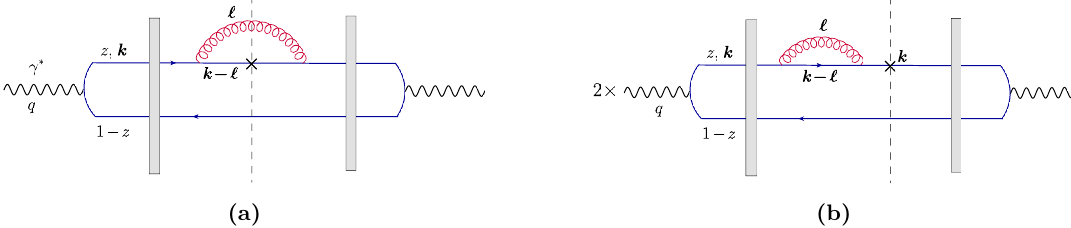
Figure 13. The NLO graphs encoding the final-state evolution of the measured quark. (a) A real gluon emission. (b) A virtual gluon emission. Graph (b) is multiplied by a factor of 2 to account for the identical contribution where the gluon emission is associated with the quark in the complex conjugate